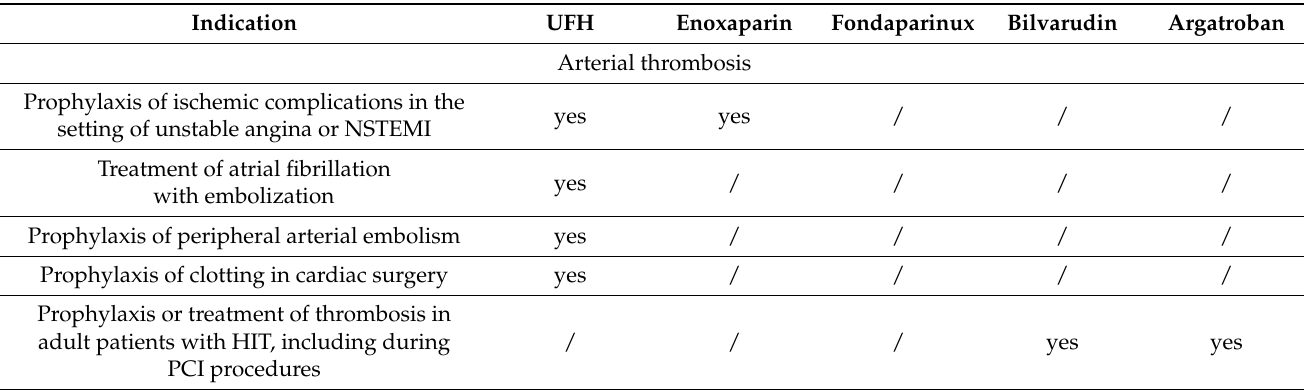
Table 5. Indications for the parenterally administered anticoagulants unfractionated heparin (UFH), enoxaparin, fondaparinux, argatroban, and bilvarudin. * based on study using another LMWH,